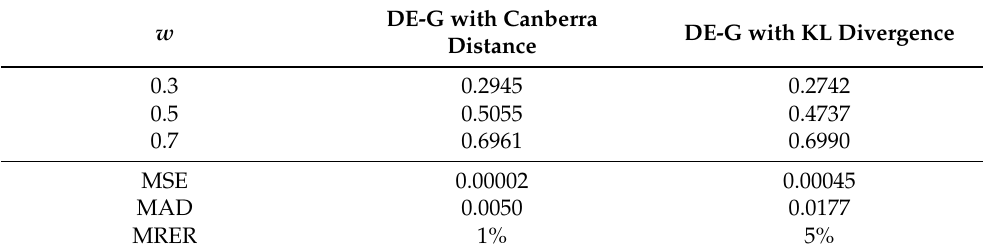
Table 3. Speckle noise weight estimation. The strength of distortion is determined by the weight of the speckle noise model as shown in Equation